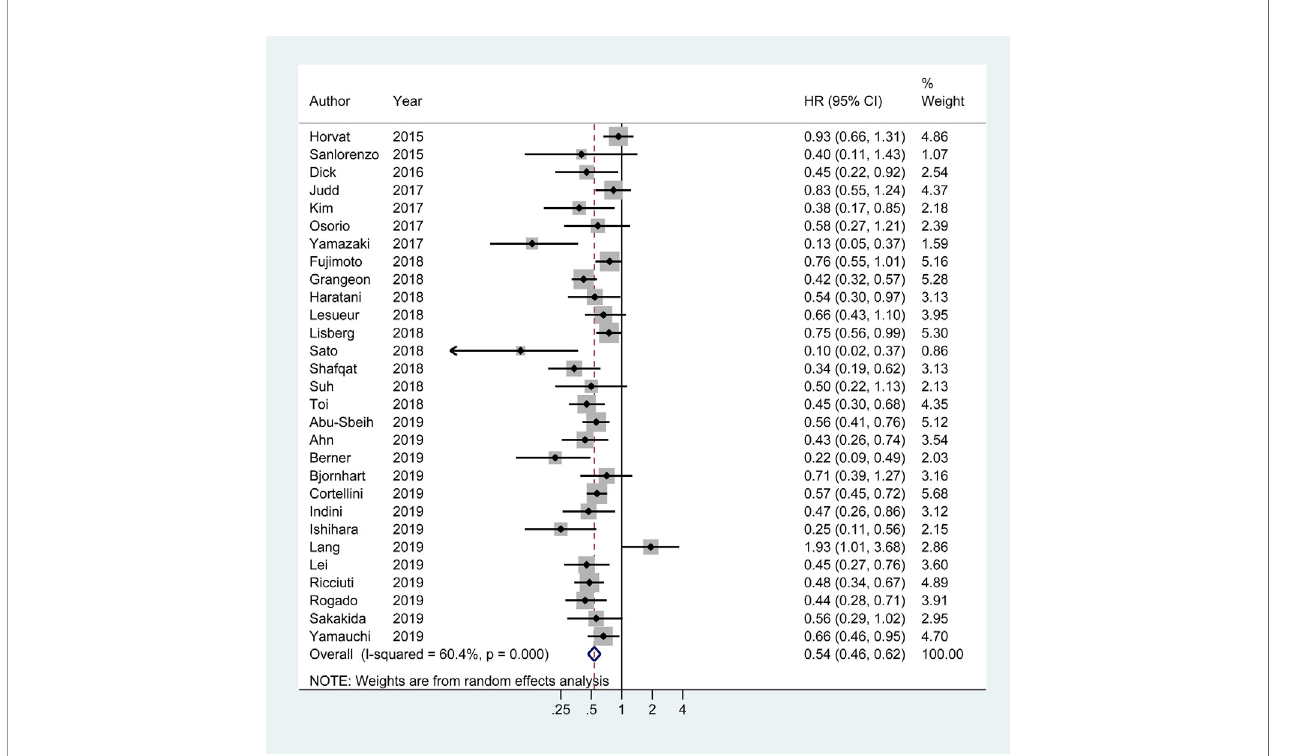
FIGURE 3 | Forest plot of the association of immune-related adverse events with progression free survival (PFS) in cancer patients receiving immune checkpoint inhibitors. HR, hazard ratio; CI, con fi dence